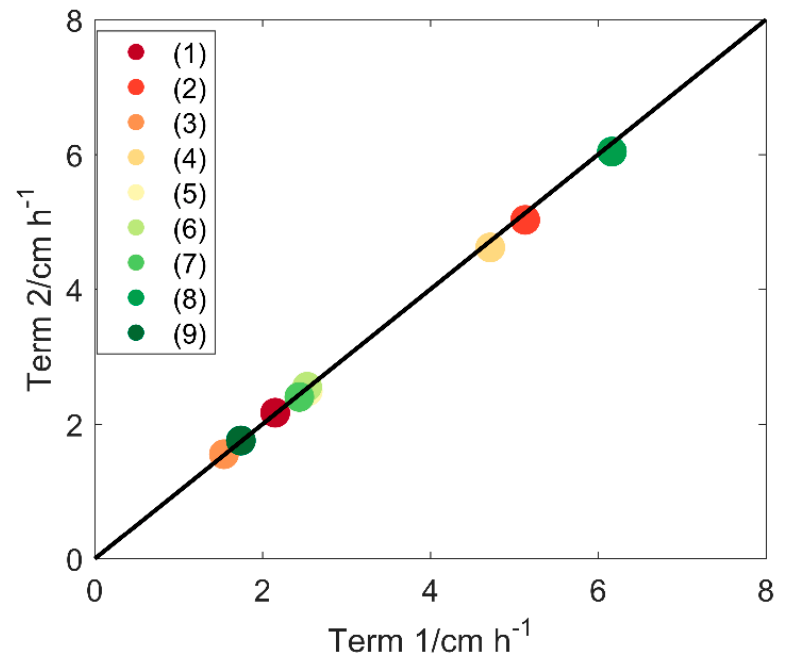
Figure 3. Mean bias in gas transfer velocity (k) for CO 2 estimated from term 1 (measured bias in f(U)) and term 2 (bias correction k b from new model) of Equation (9) over the period spanning 1990 to 2018 for the parameterizations presented in Table 1.